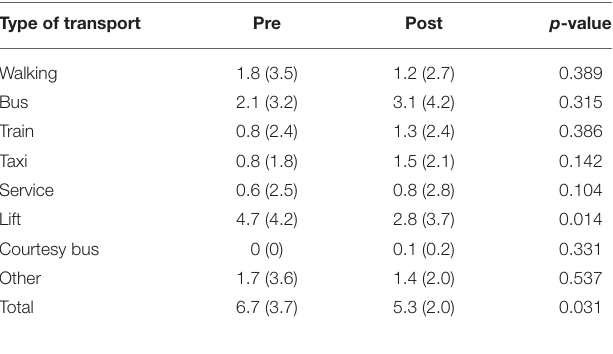
TABLE 4 | Pairwise comparison of before vs. after the intervention period ( n = 18) M (SD).